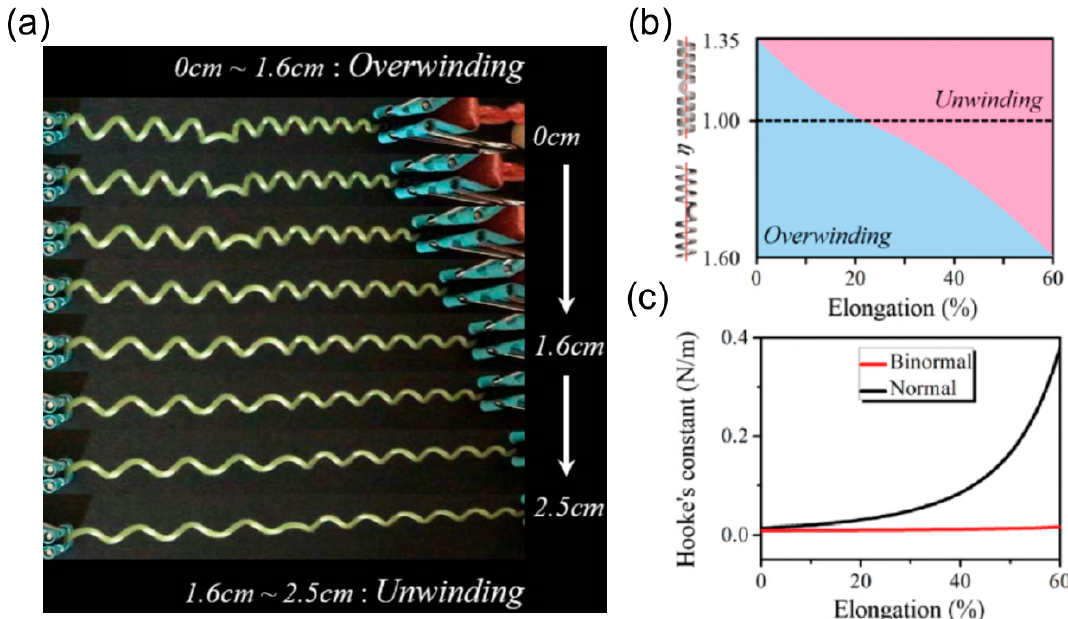
Figure 15. Mechanical properties of a helix with one perversion. ( a ) The tendril exhibits over-winding initially and then unwinds itself during pulling; ( b ) The phase diagram separating the unwinding and over-winding regimes in terms of elongation and η ; ( c ) The Hooke’s constant of a scrolled SiGe/Si/Cr nanohelix with the normal or binormal cross-section under extension. ( a – c ) are from [106], reproduced with permission from The Royal Society of Chemistry.